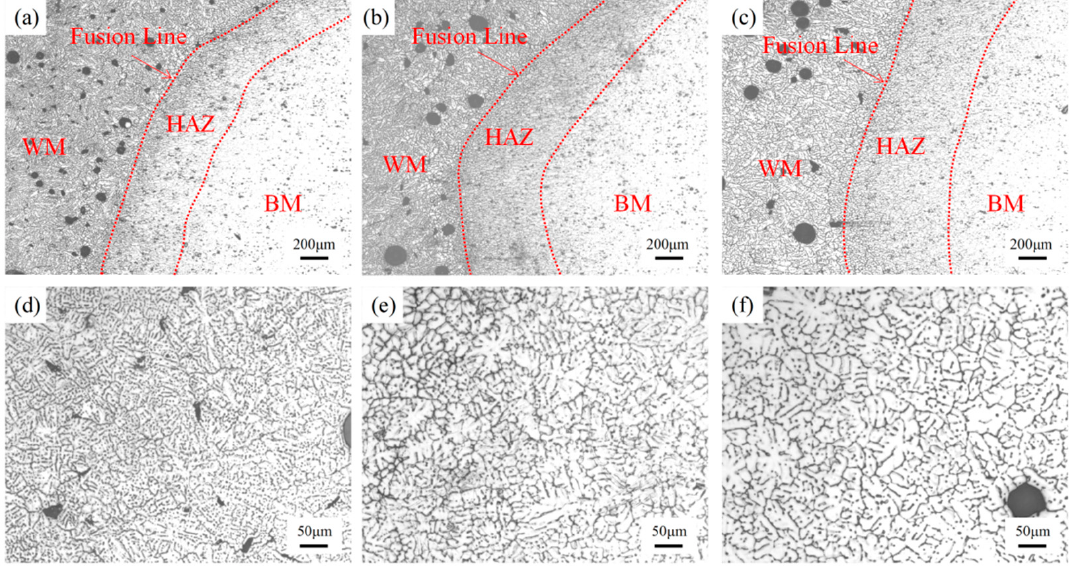
Figure 6. Microstructure of welded joints under different welding currents: ( a ) 90 A; ( b ) 105 A; ( c ) 120 A; ( d ) 90 A; ( e ) 105 A; ( f ) 120 A.